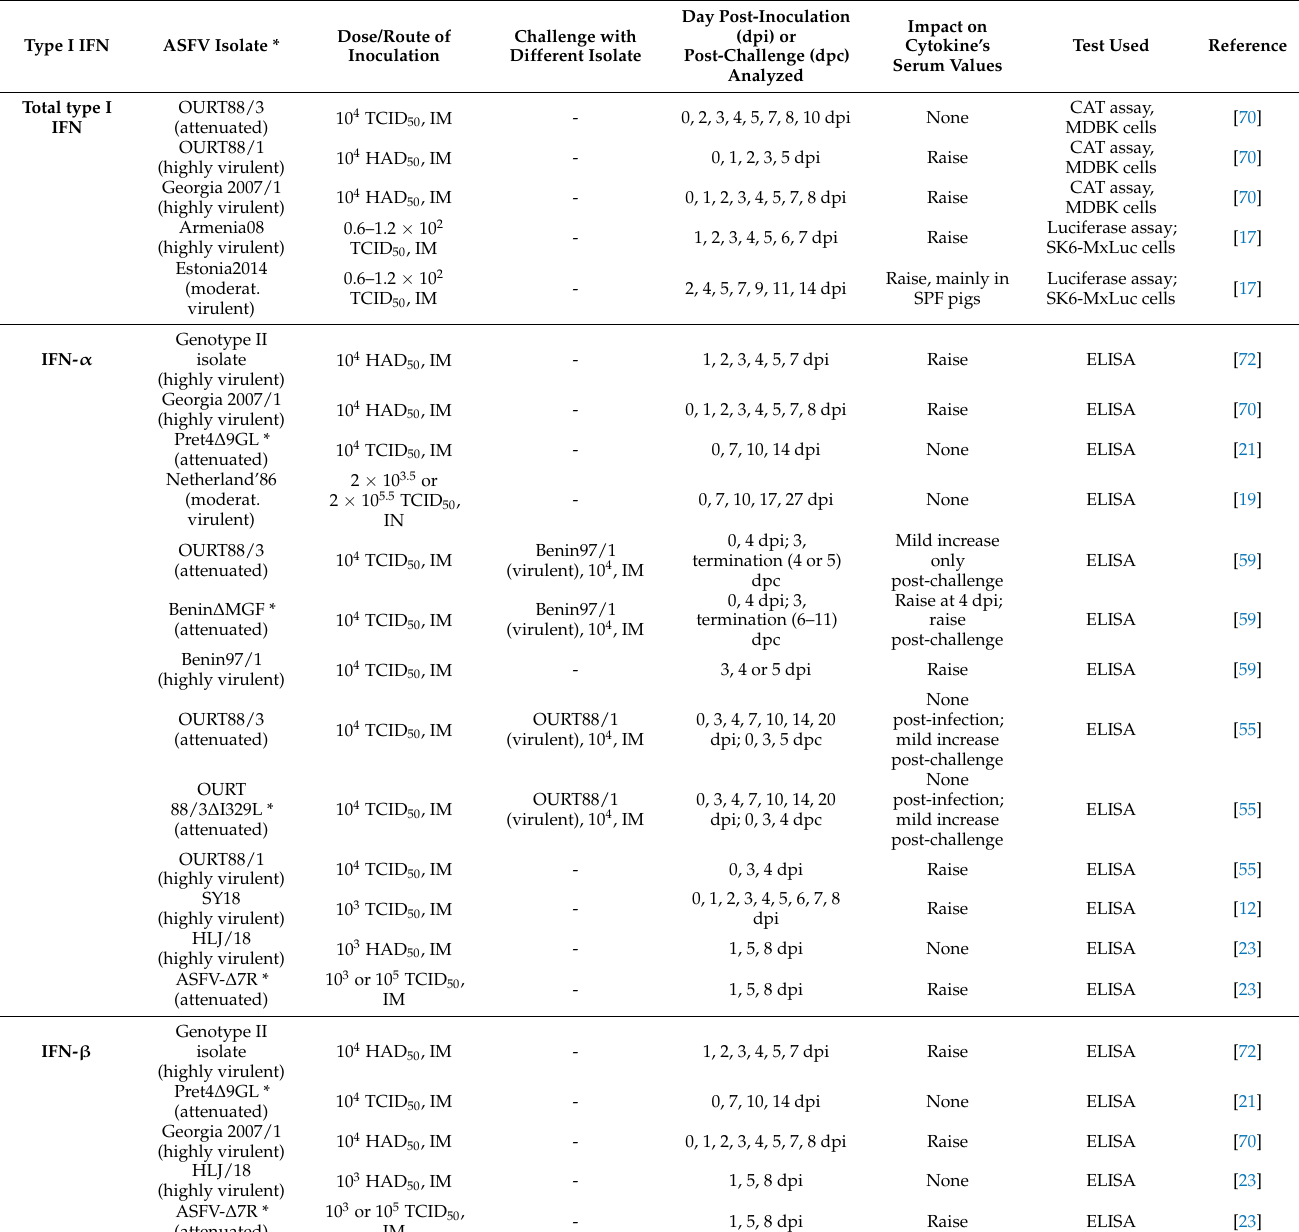
Table 2. Modulation of serum levels of type I IFN in domestic pigs infected with ASFV strains of diverse